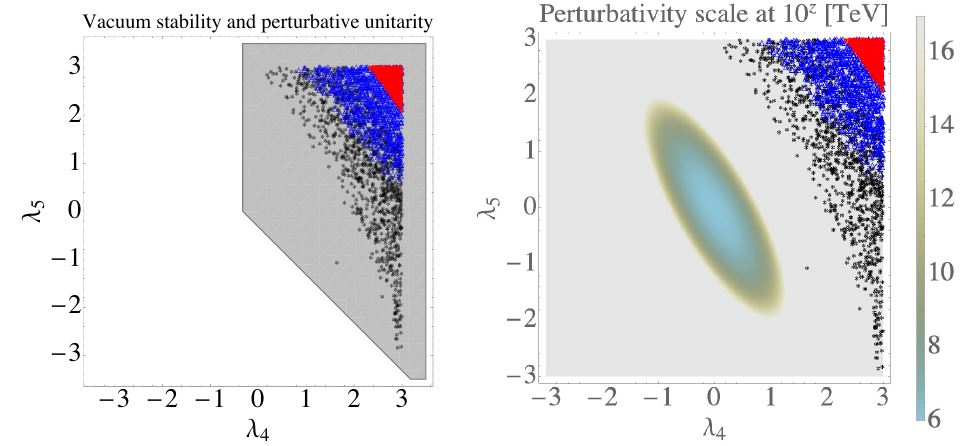
Figure 6 . Left panel: theoretical constraints on the triplet model from tree-level vacuum stability and perturbative unitarity. Right panel: constraints from one-loop perturbativity. In each panel, the black, blue and red points correspond to our setup one, three and four, respectively.